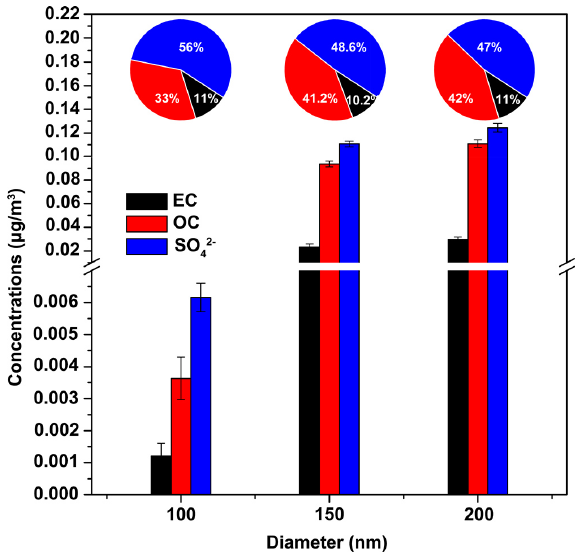
Figure 8. Quantitative results of atmospheric nanoparticle sub- groups collected by a quartz filter membrane on 22 March